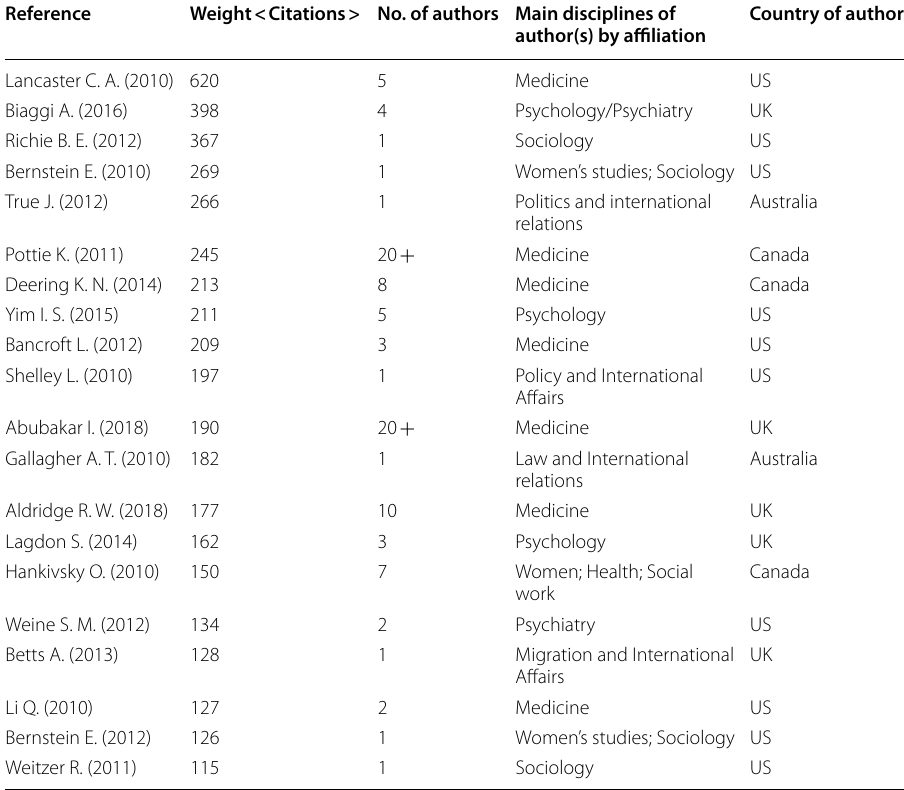
Table 3 The 20 most cited documents in order of citation score and other relevant attributes